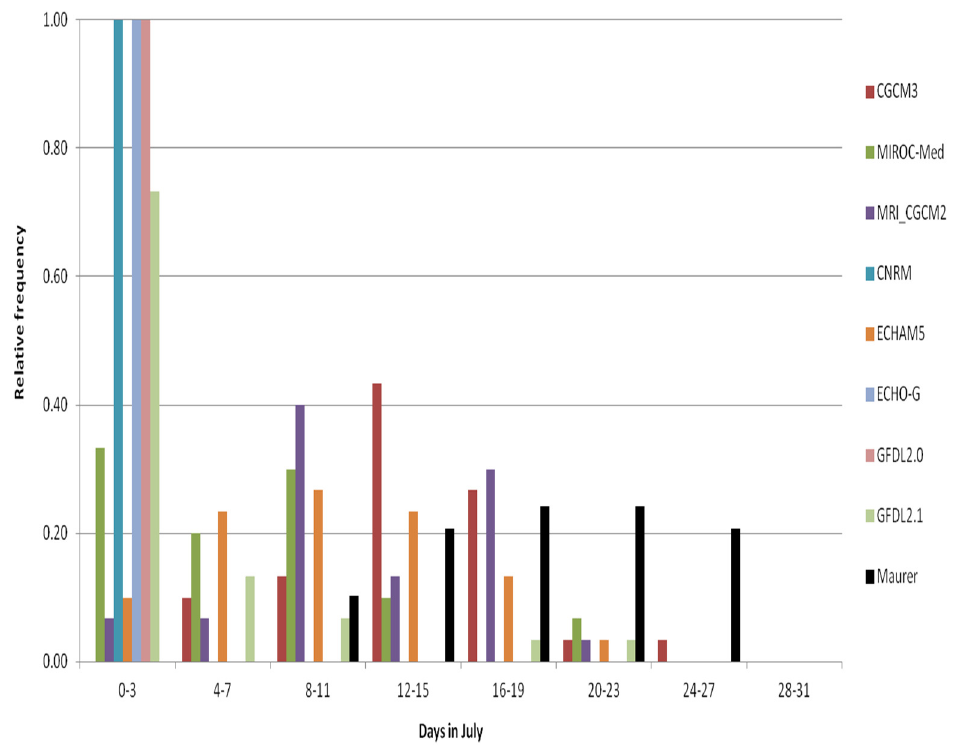
Figure 8. Histogram of HD30 in July for a grid cell that overlays the Washington DC area, based on the individual 8 CMIP3 GCMs re-gridded to 2° × 2° resolution—GCM_2deg data, 1971–2000.